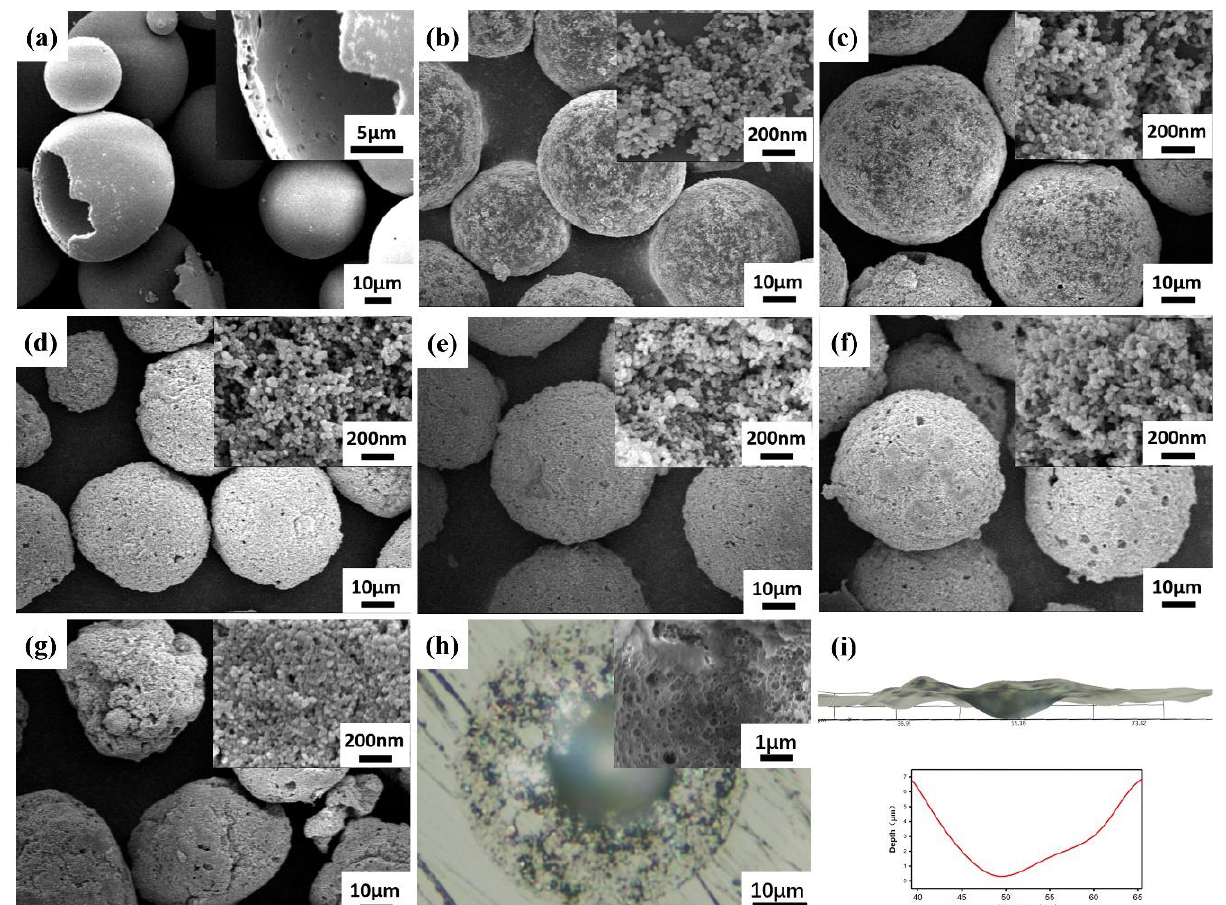
Figure 1. Scanning electron microscopy (SEM) images of ( a ) PSF microsphere. ( b – g ) TiNPs/PSF-x composite microspheres (x means the weight ratio (0–0.88) of TiO 2 catalyst to PSF), ( b ) x = 0.08, ( c ) x = 0.24, ( d ) x = 0.40, ( e ) x = 0.56, ( f ) x = 0.72, ( g ) x = 0.88 show the overall morphology of composite microspheres, and the inner SEM images show 100k times surface topography. ( h ) The cross-section optical micrograph of the TiNPs/PSF-0.40 microsphere and the inner SEM images show the inner surface of composite microsphere. ( i ) 3D stereo imaging and depth simulation analysis.